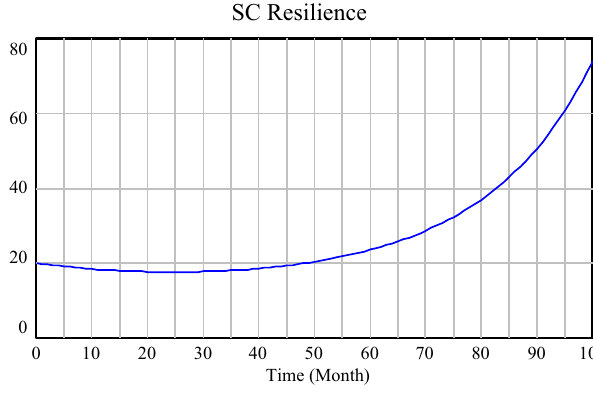
Figure 6. Prediction of resilience of